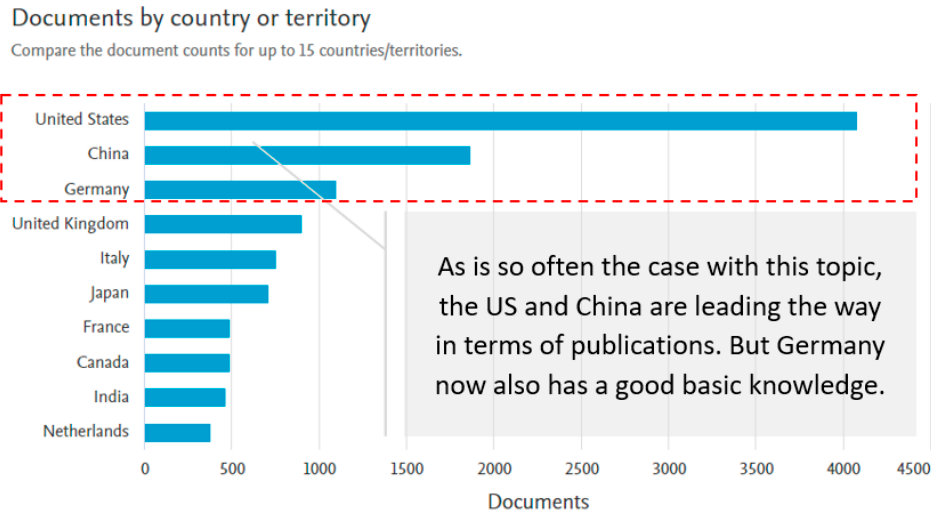
Figure 15. SCOPUS Search: advanced AND production AND control—Documents by Country.